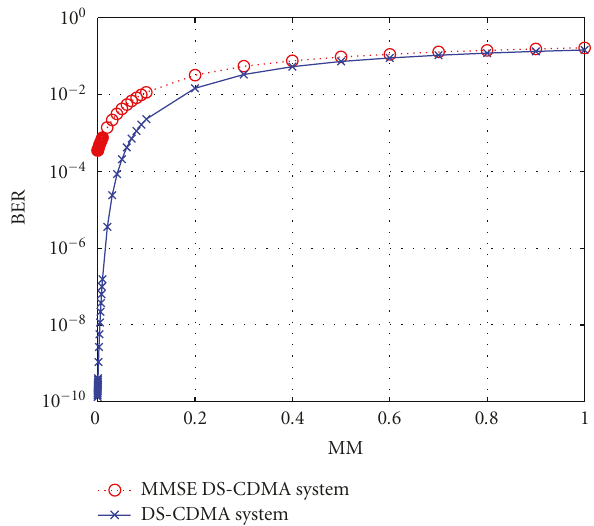
Figure 6: BER versus MM performances of the MMSE DS-CDMA system ( ··· ◦ ··· ) and the proposed DS-CDMA system ( − × − ), when l = 0, M = 7, L = 5, N = 5, and E b / N 0 = 20dB in all cases.